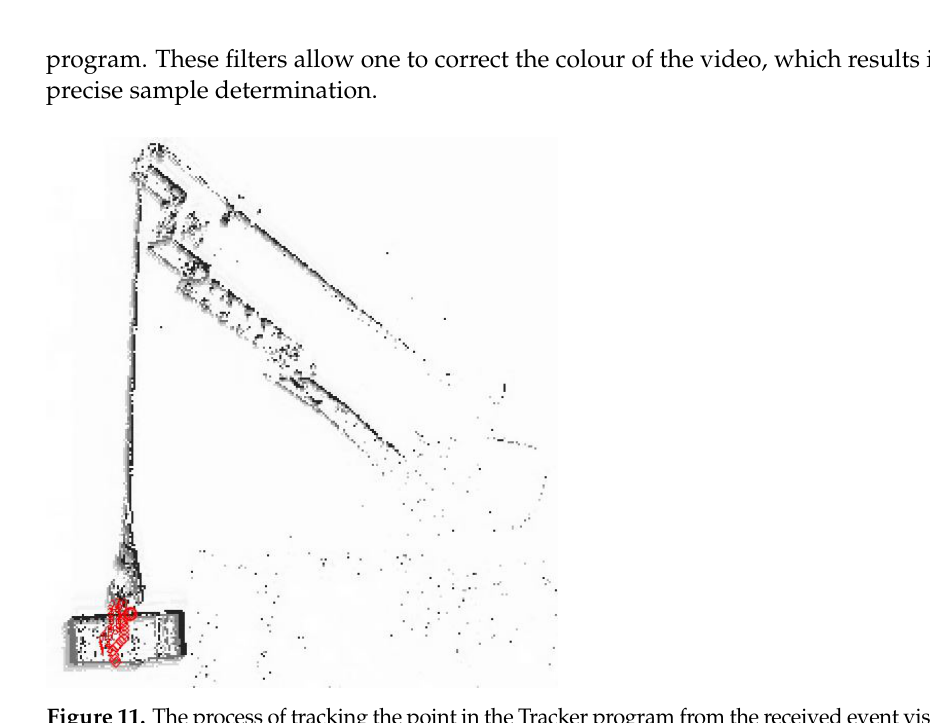
Figure 11. The process of tracking the point in the Tracker program from the received event visualization.